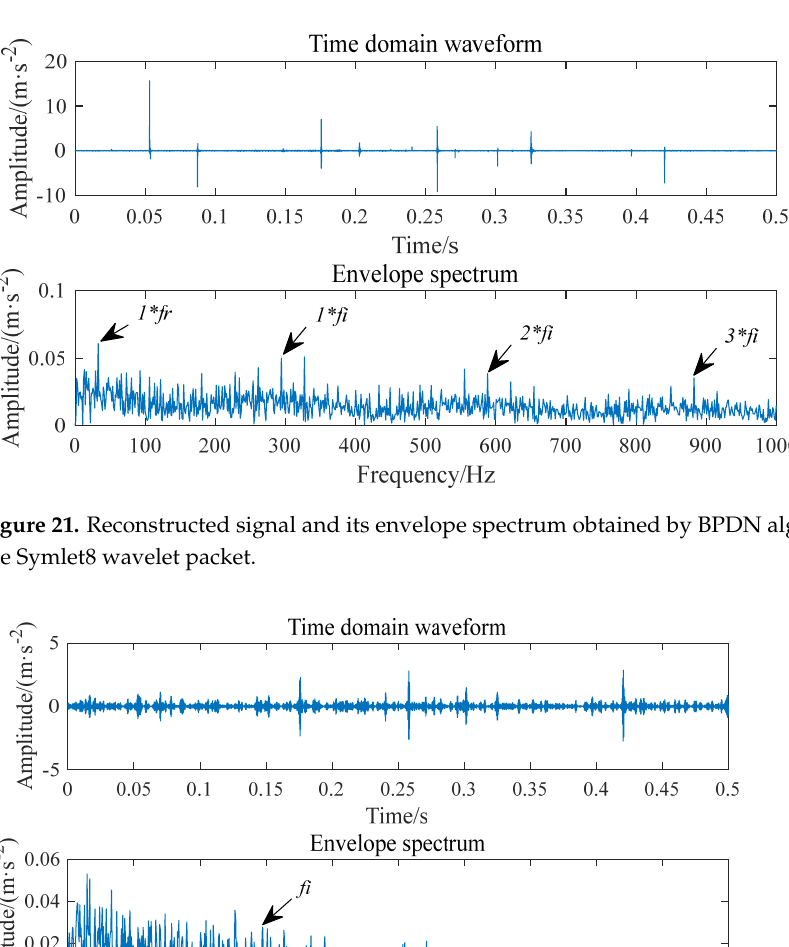
Figure 20. Results obtained with SISC based on a learning dictionary: ( a ) is the base atom obtained by learning; and ( b ) is the envelope spectrum of the reconstructed signal corresponding to the atom.